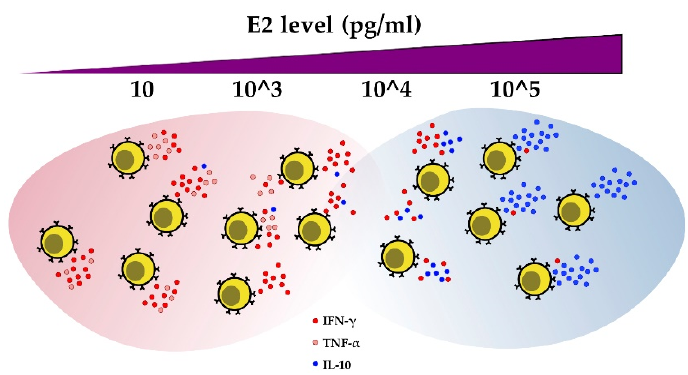
Figure 4. E2 regulates cytokine production in CD4+ T cells. As estrogen levels increase, IFN- γ and TNF- α production decreases, while IL-10 secretion increases.